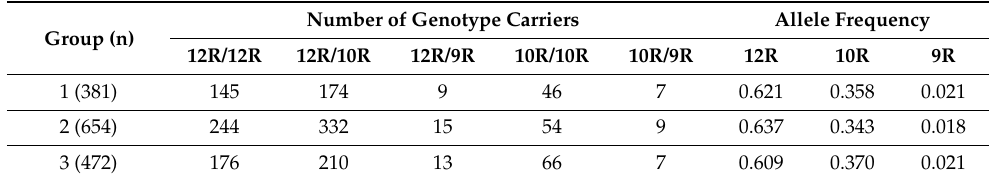
Table 4. Numbers of genotype carriers and allele frequencies for VNTR STin2 of the SLC6A4 gene in the three groups of adolescents (1: born in 1982–1985, 2: in 1992–1995, and 3: in 2002–2005); n: the number of all such carriers in a group, R: the number of repeats.